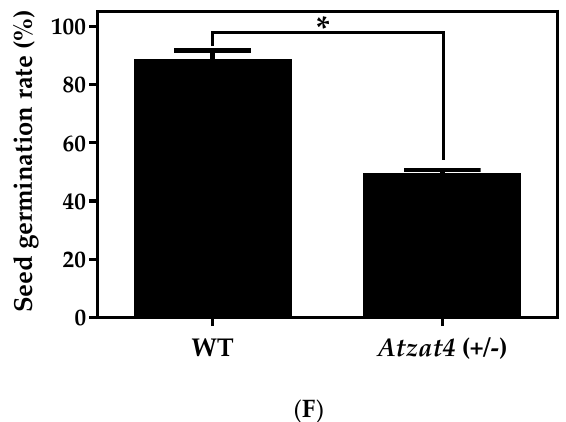
Figure 6. Fertility in Atzat4 (+/−) compared to WT in Arabidopsis thaliana . ( A ) Seeds per silique quantification ( n = 10 siliques in triplicate). ( B ) Discolored siliques with developed seeds and unfertilized ovules (white arrowheads). ( C ) Silique size quantification ( n = 10 siliques in triplicate). ( D ) Viable seeds quantification using Tetrazolium test ( n = 100 seeds in triplicate). ( E ) Tetrazolium test, red staining shows viable seeds, unstained unviable seeds and pink stain indicates dead tissue. ( F ) Quantification of germinated seeds ( n = 100 seeds in triplicate). In ( A , C , D , F ) data correspond to the mean ± SE; **** p < 0.0001, ** p < 0.01, * p < 0.05. In ( B , E ), bars = 1 mm. For details, see Section